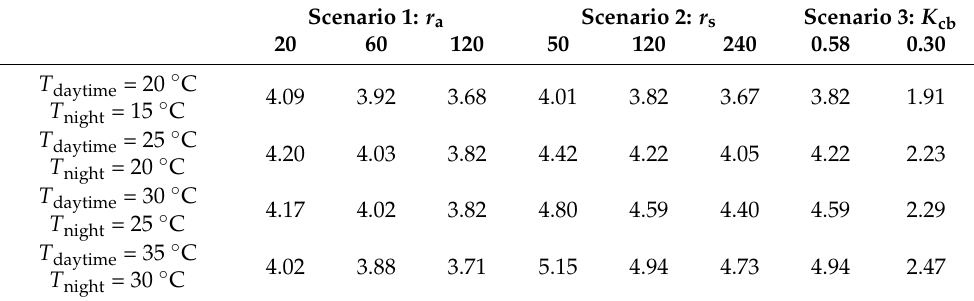
Table 1. The sensitivity analysis indicated the effects of parameterization themes of different models on daily ET estimates (mm m − 2 day − 1 ). The background environment in scenario 1 included incident solar radiation ( R s ↓ ) of 19.0 MJ m − 2 day − 1 , daily relative humidity ( RH ) of 70% and the flooded bare land. Other model parameters were set at optimal levels except for the one used for the specific scenario analysis. In scenario 2, to evaluate the effects of canopy resistance ( r s , s m − 1 ), R s ↓ was set at 19.0 MJ m − 2 day − 1 , with daily RH of 70%, surface albedo of 0.18, and leaf area index ( LAI ) of 4.0 m 2 m − 2 . In scenario 3, there were the same climate variables as in scenario 1 but with variying K cb